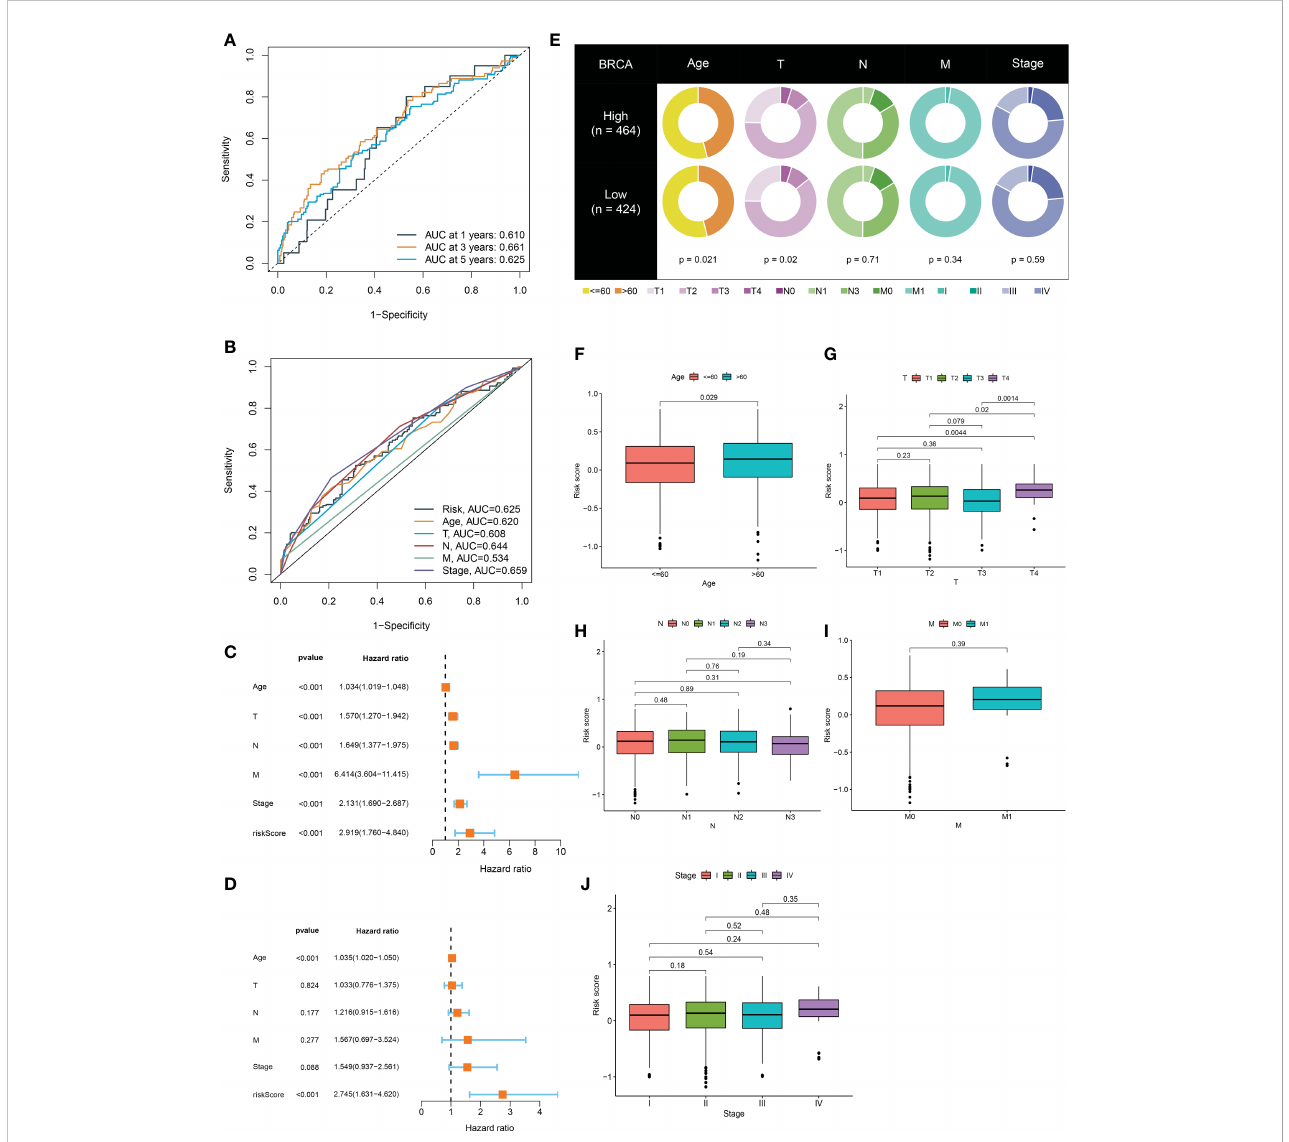
FIGURE 4 The risk model veri fi cation and its relationship with clinical characteristics. (A) ROC curve to evaluate 1, 3, and 5-year survival prediction ef fi ciency of the risk model in the TCGA cohort. (B) ROC curve to assess prediction ef fi ciency of the risk model, age, T stage, N stage, M stage, and pathological stage. (C, D) Univariate and multivariate Cox analysis showed that the risk model could be an independent prognostic indicator for BRCA patients (P<0.001). (E) Differences of clinical features in the high-risk and low-risk groups. (F-J) Clinicopathological characteristics evaluation by the risk